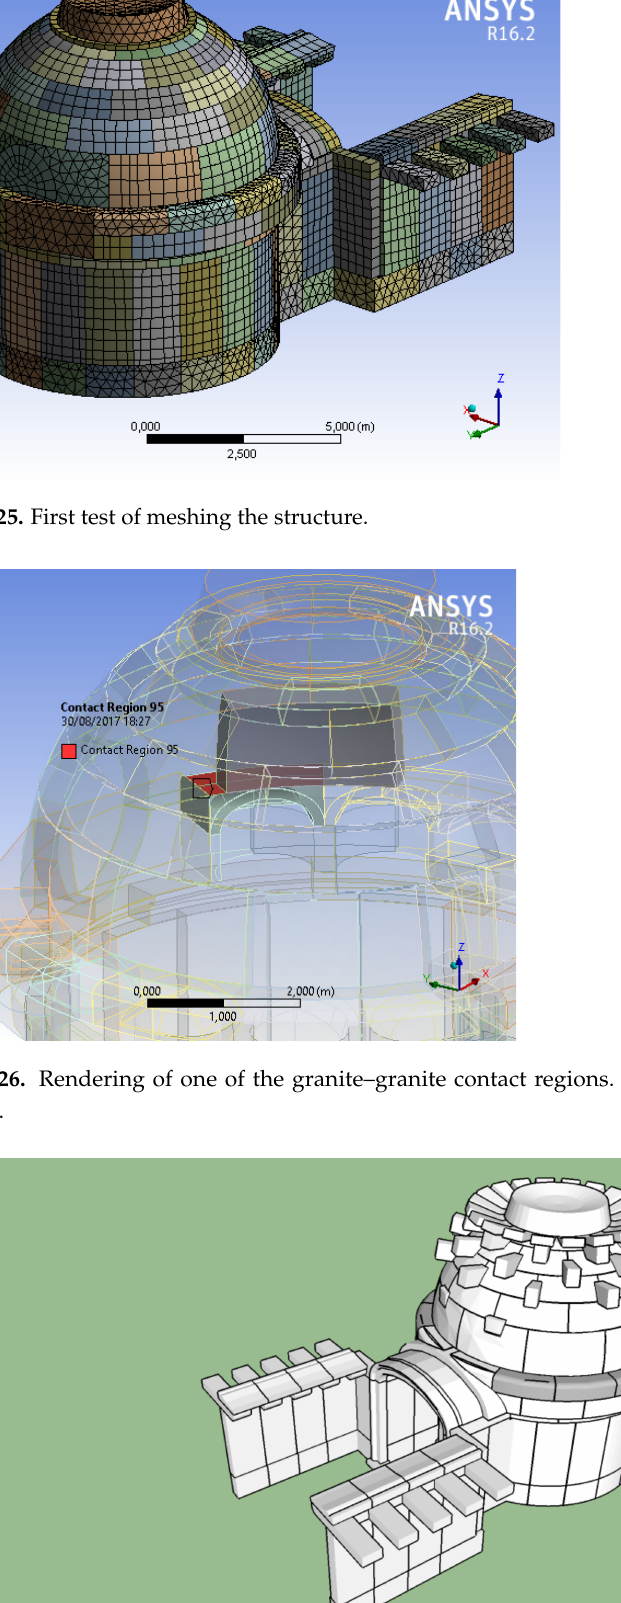
Figure 24. Process of importing the model to ANSYS.